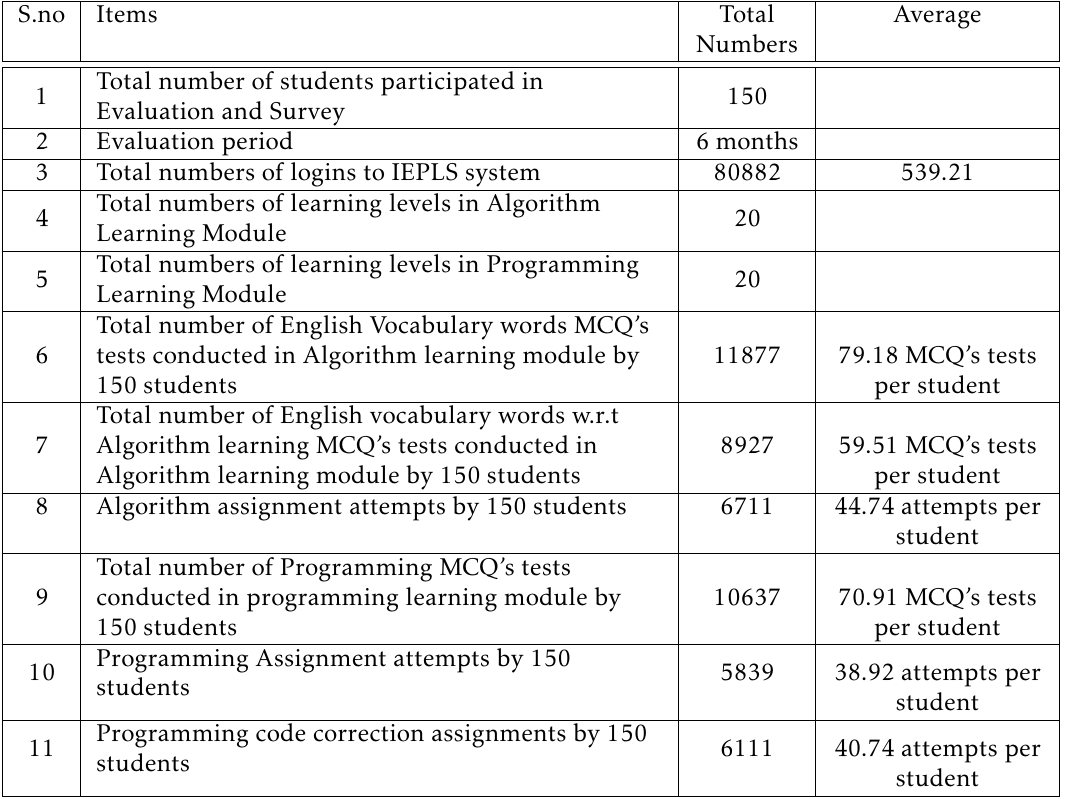
Table 1. IEPLS System usage statistics retrieved from log